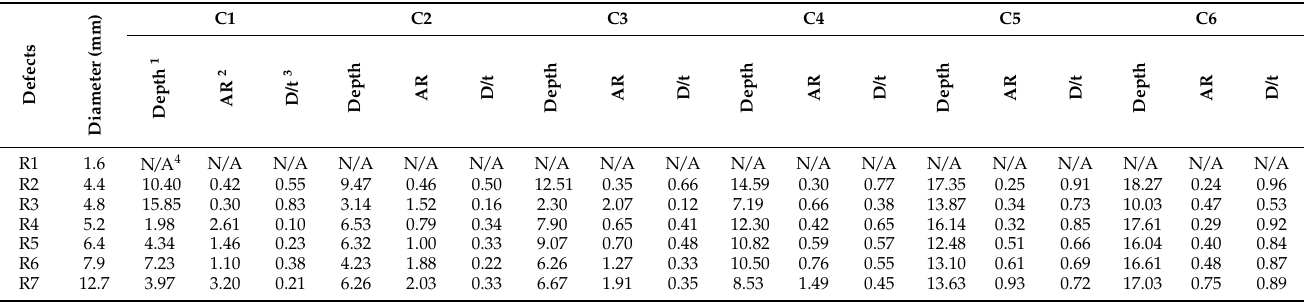
Table 6. Characteristics of the defects shown in Figure 2 created on the internal west side of the tank (wall thickness, t = 19.1 mm = 0.75